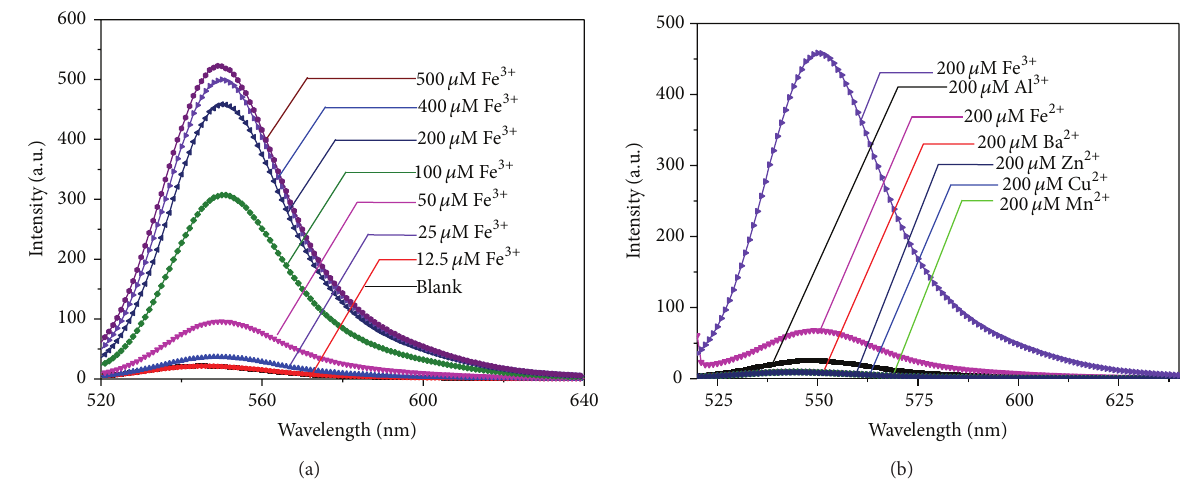
Figure 2: Fluorescence spectra of FD2 (0.1 𝜇 M) in 3%NaCl solution containing different concentrations of Fe 3+ ions (a) and other metal ions (b).